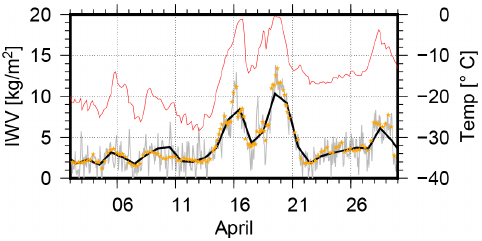
Figure 12. GNSS-based IWV: hourly values (gray) and daily aver- aged (black); radiosonde-based IWV (orange stars); air temperature from ERA5